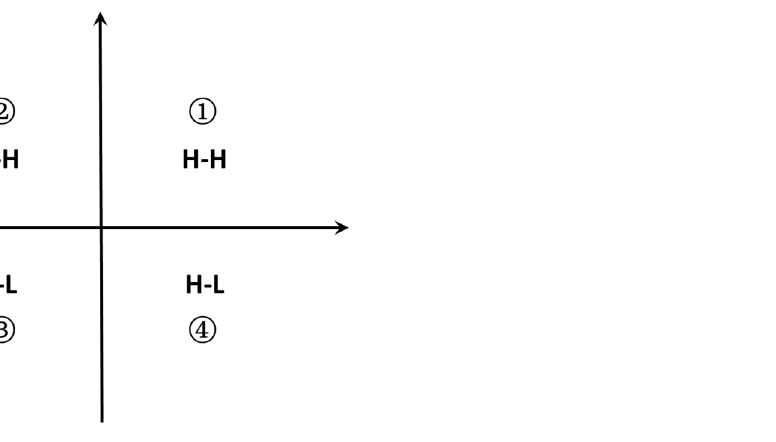
Figure 2. Scatter plots of local Moran’I in quadrants and the significance of correlation of a station with adjacent stations.